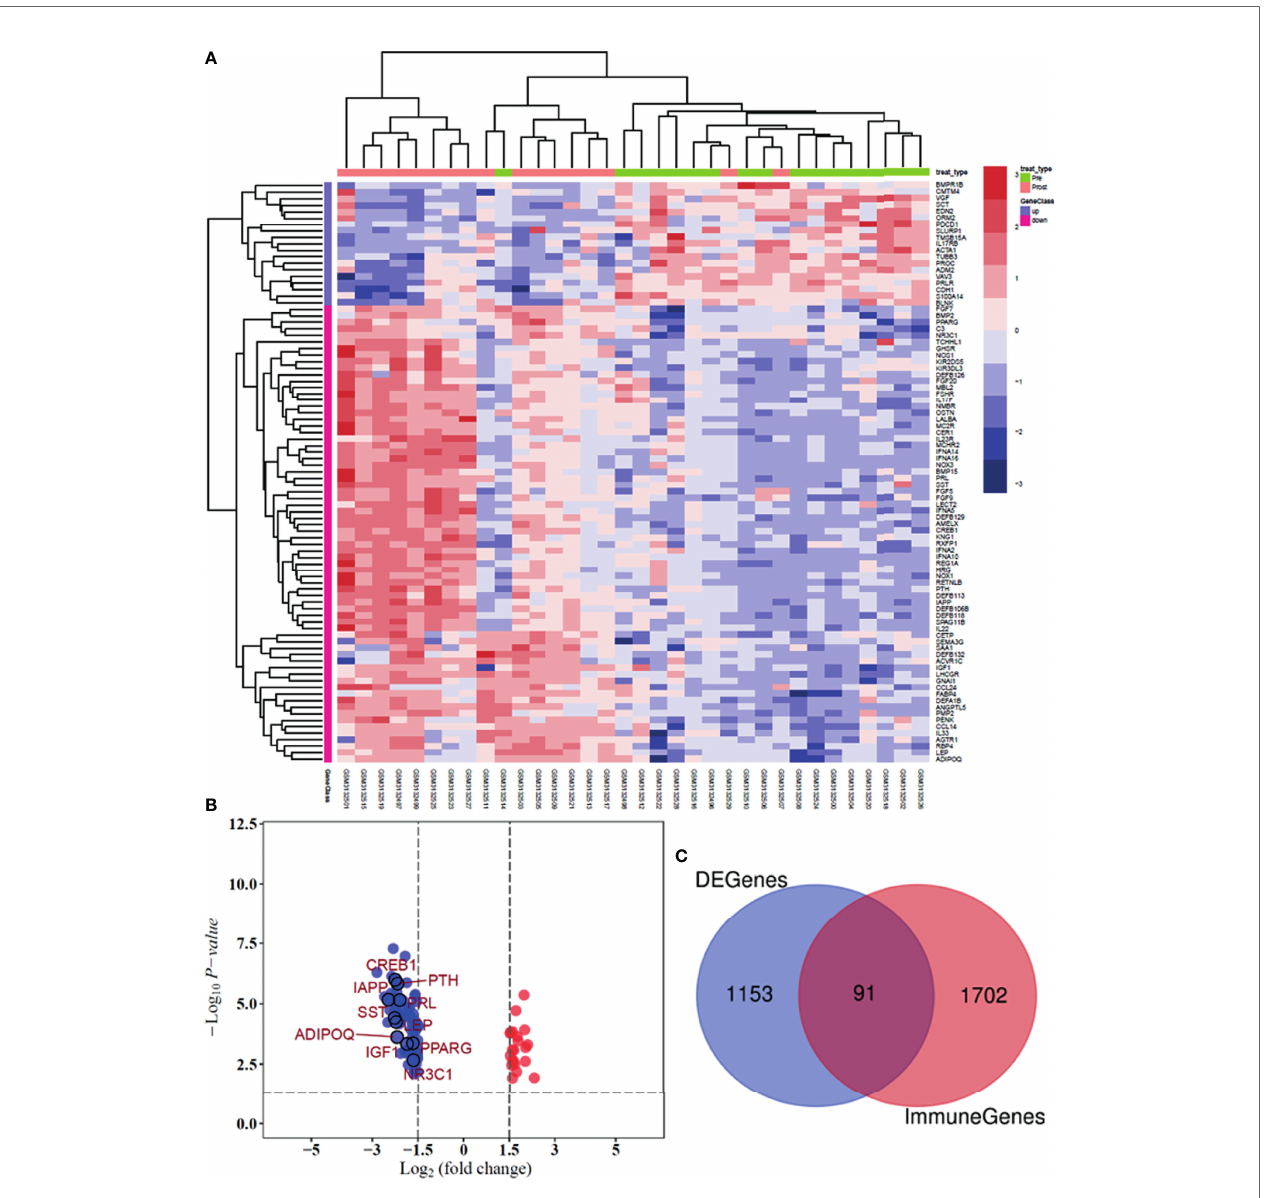
FIGURE 3 | Heatmap and volcano plot presenting the signi fi cant immune-related DEGs between patients pre- and posttreated by trastuzumab. (A) Heatmap shows the differential expression of 91 DEGs in breast tumor tissues. (B) The volcano plot was illustrated the signi fi cant difference between genes and 10 hub genes. (C) Venn plot was used to identify the common immune-related genes between GSE 114082 dataset and the ImmPort